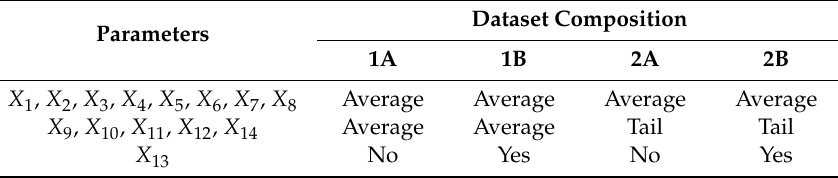
Table 4. Composition of the datasets used in the